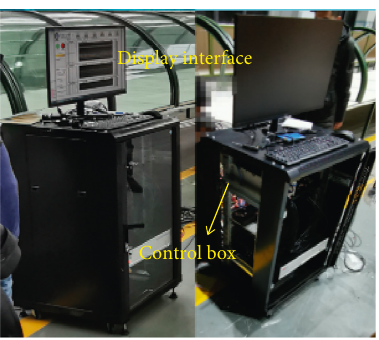
Figure 8: The main